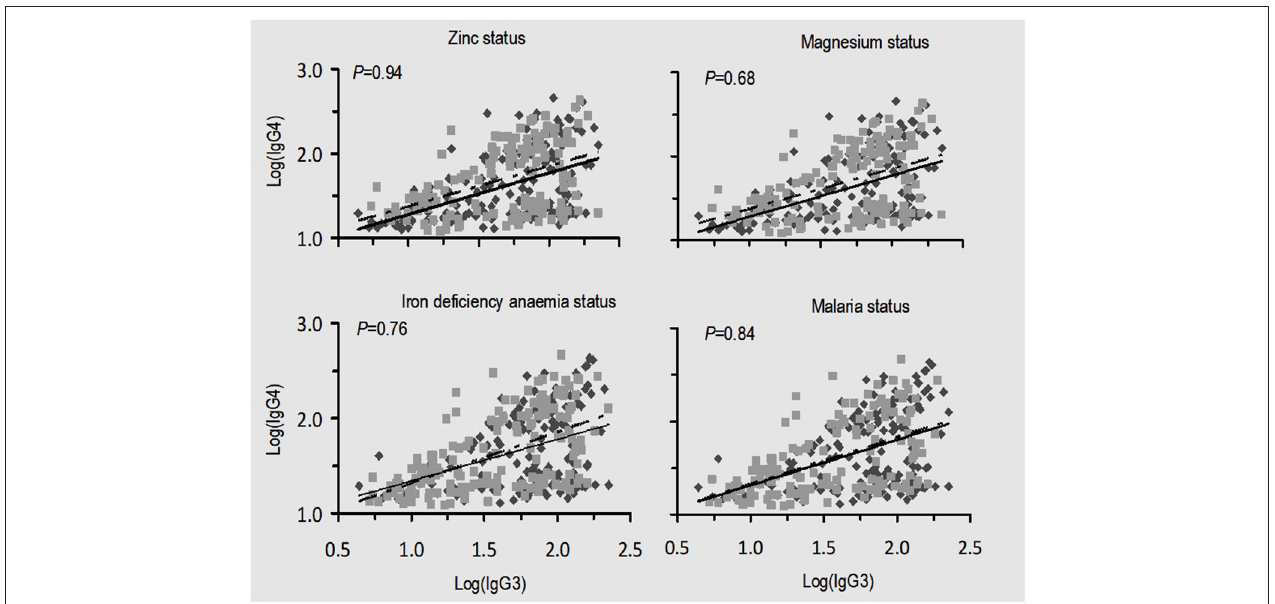
FIGURE 3 | Relationship between malaria-specific plasma IgG3 and IgG4 under different situations of nutrition and malaria status. There were no significant differences between slopes in all four conditions being compared as indicated by p -values. Scatter spots (black): zinc and magnesium replete, absence of iron deficiency anemia, and absence of malaria infection; scatter spots (gray): zinc, magnesium deficiency, and iron deficiency anemia and malaria infection. The solid black and dashed lines are their corresponding regression